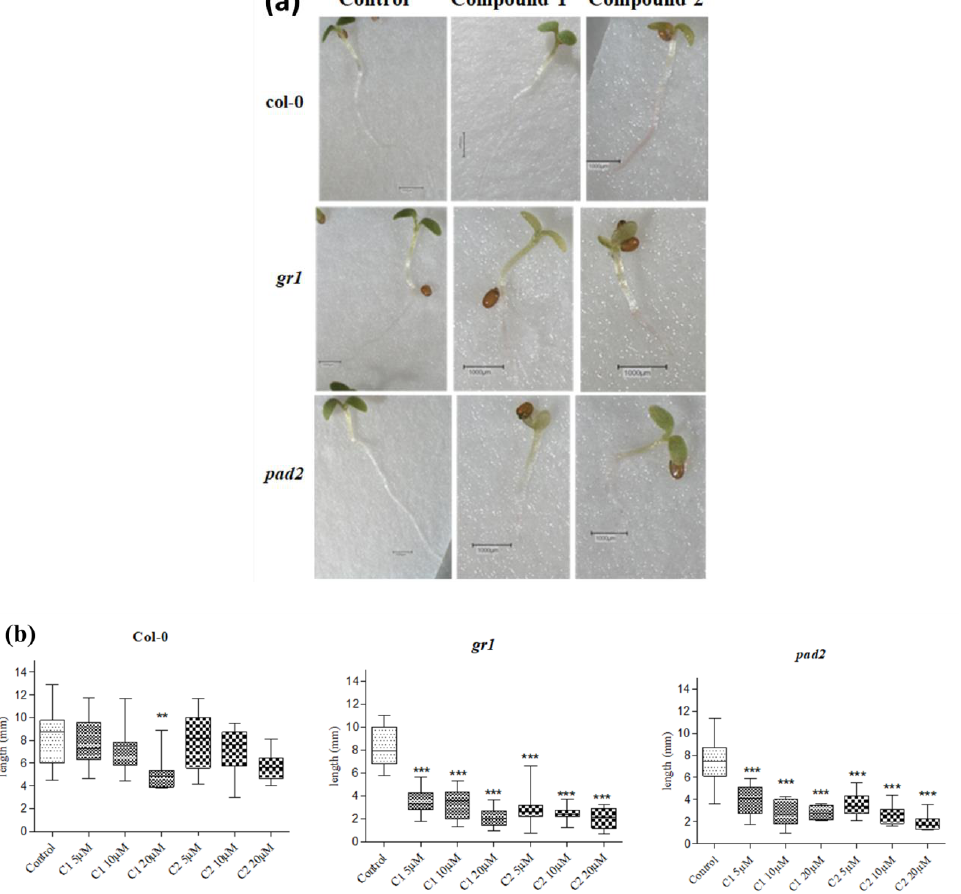
Figure 8. Effect of selenocyanates on Arabidopsis root growth. ( a ) Shows the phenotypes of Col-0 (wt), pad2 and gr1 seedlings observed after three days of continual exposure to 20 μM of selenocyanates in the growth medium. Scale bar = 1 mm. ( b ) Shows the effect of continual exposure to 5, 10 and 20 μM of selenocyanates on root growth of Col-0 (wt), pad2 and gr1 seedlings. The box plots show the range of individual measurements, the mean ± standard deviation, and the median value indicated as a horizontal line. C1—Compound 1 and C2—Compound 2. Values represent mean ± S.D. ** p < 0.01 and *** p <